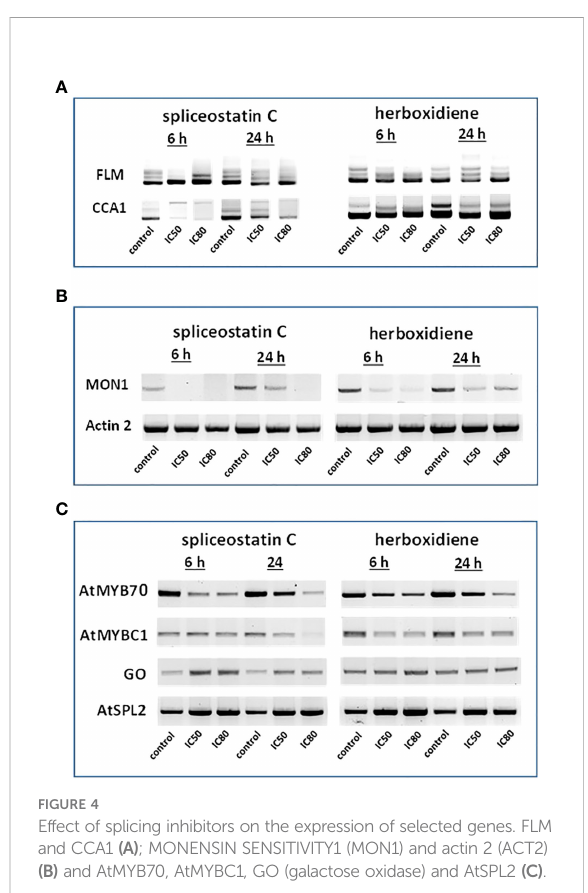
FIGURE 4 Effect of splicing inhibitors on the expression of selected genes. FLM and CCA1 (A) ; MONENSIN SENSITIVITY1 (MON1) and actin 2 (ACT2) (B) and AtMYB70, AtMYBC1, GO (galactose oxidase) and AtSPL2 (C)